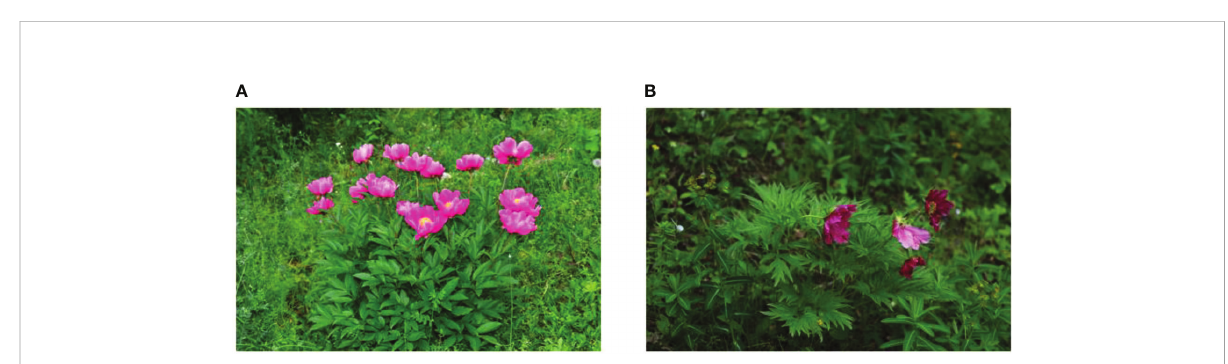
FIGURE 2 Whole plant of Paeonia. The above-ground portion of Paeonia lacti fl ora Pall (A) ; Paeonia veitchii Lynch (B) .